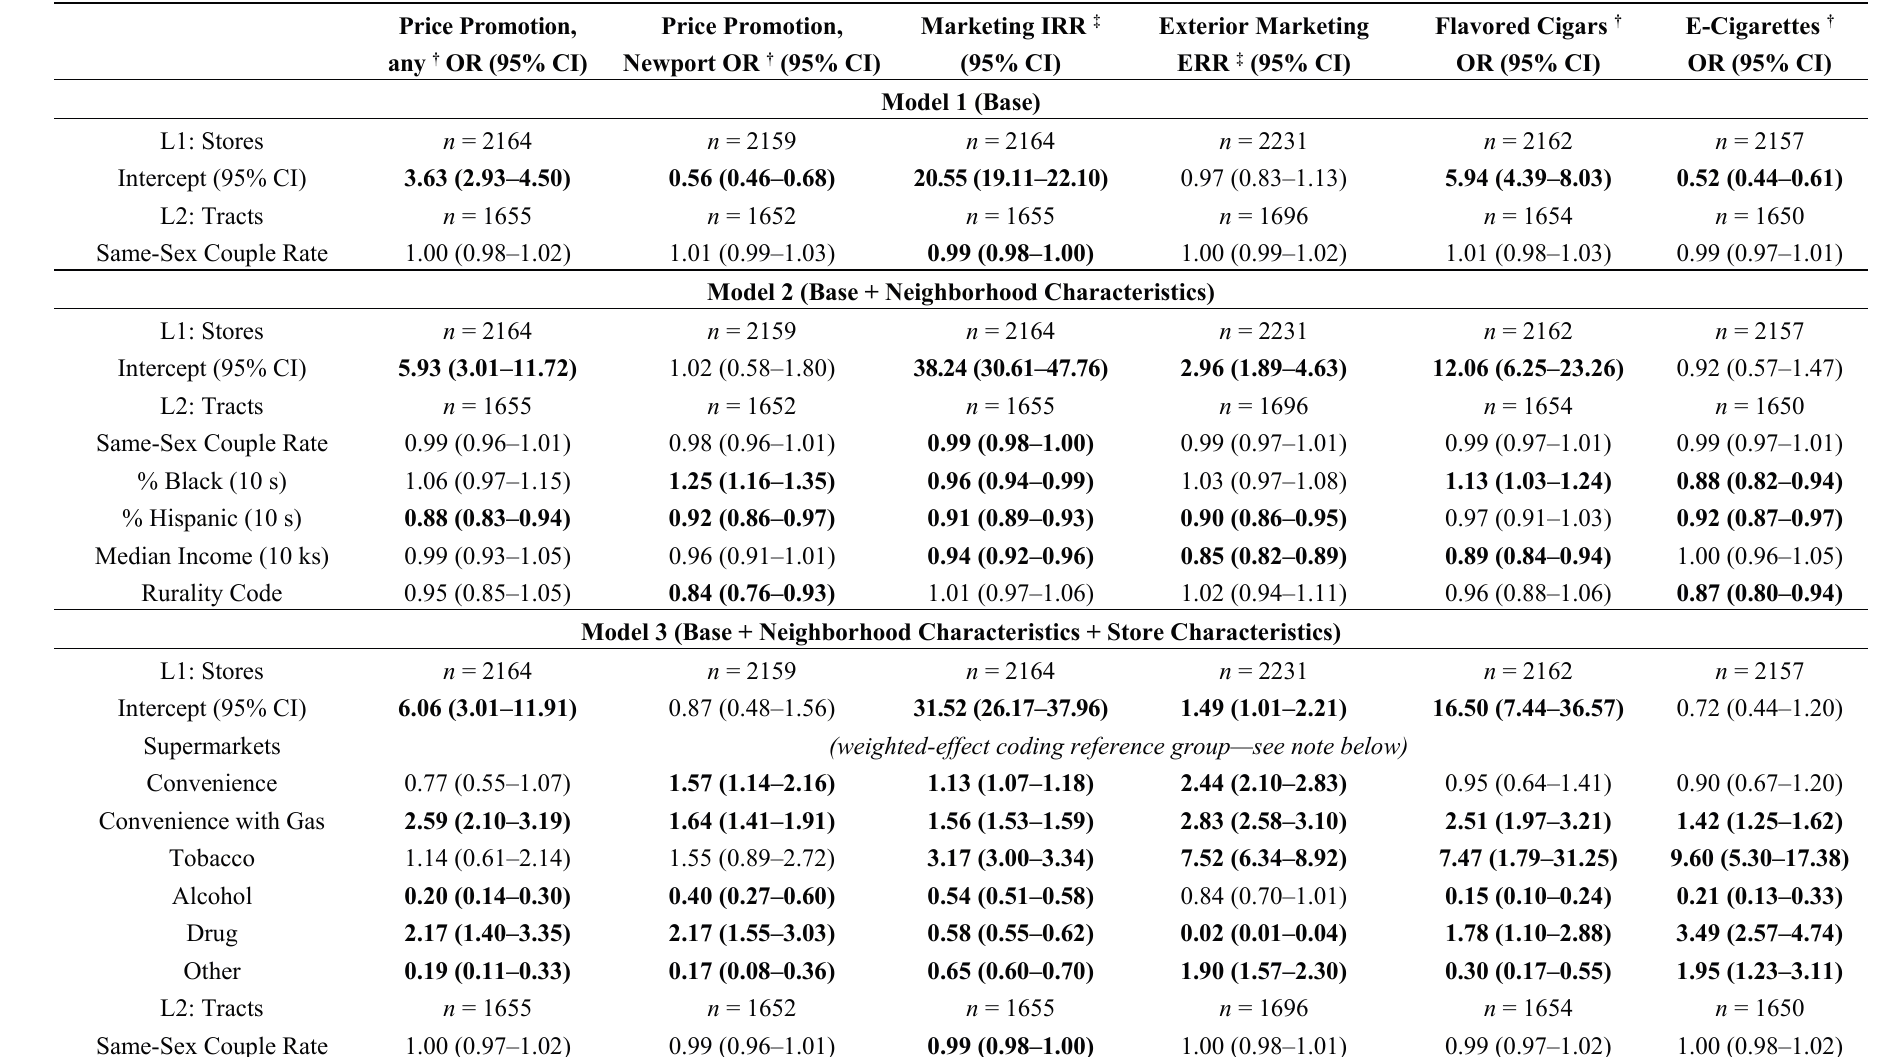
Table 3. Two-level models associating female same-sex couple rate with retailer tobacco marketing